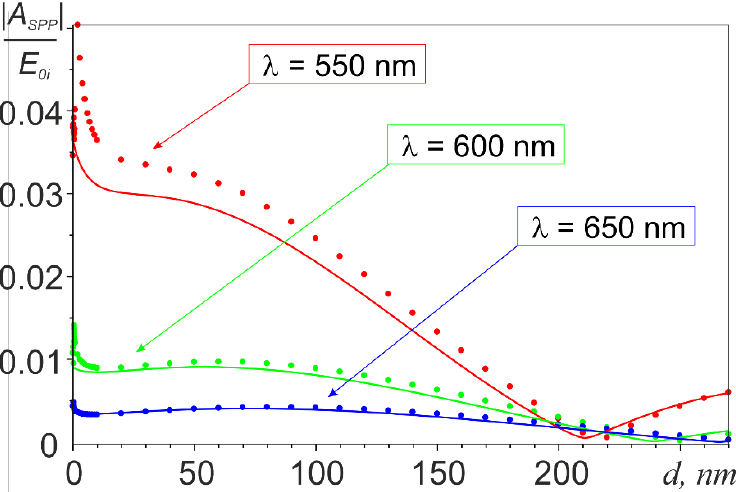
Figure 4. Dependences of the SPP excitation efficiency on the width of the gap between the nanoan- tenna and the film at a = 30 nm. Solid curves are the results of analytical calculations; dots represent numerical data.